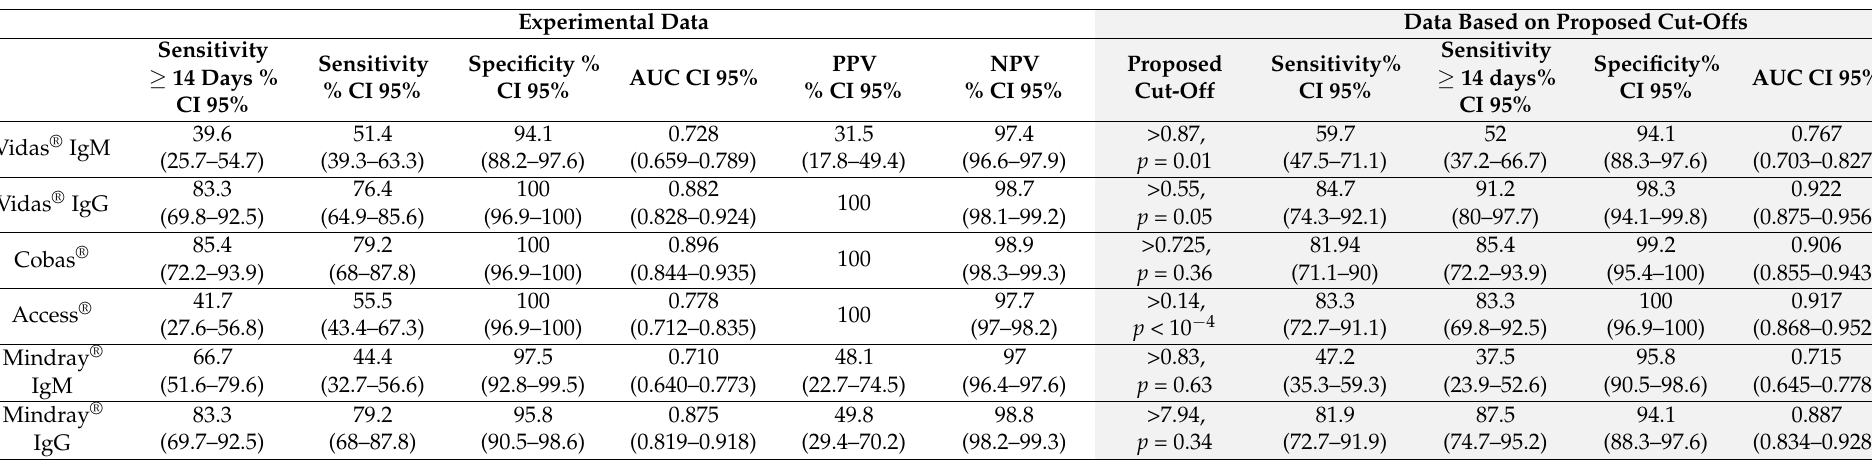
Table 2. Experimental analytical performances for the four used commercial tests for SARS-CoV-2 antibodies detection: according to the manufacture’s criteria and following the new proposed